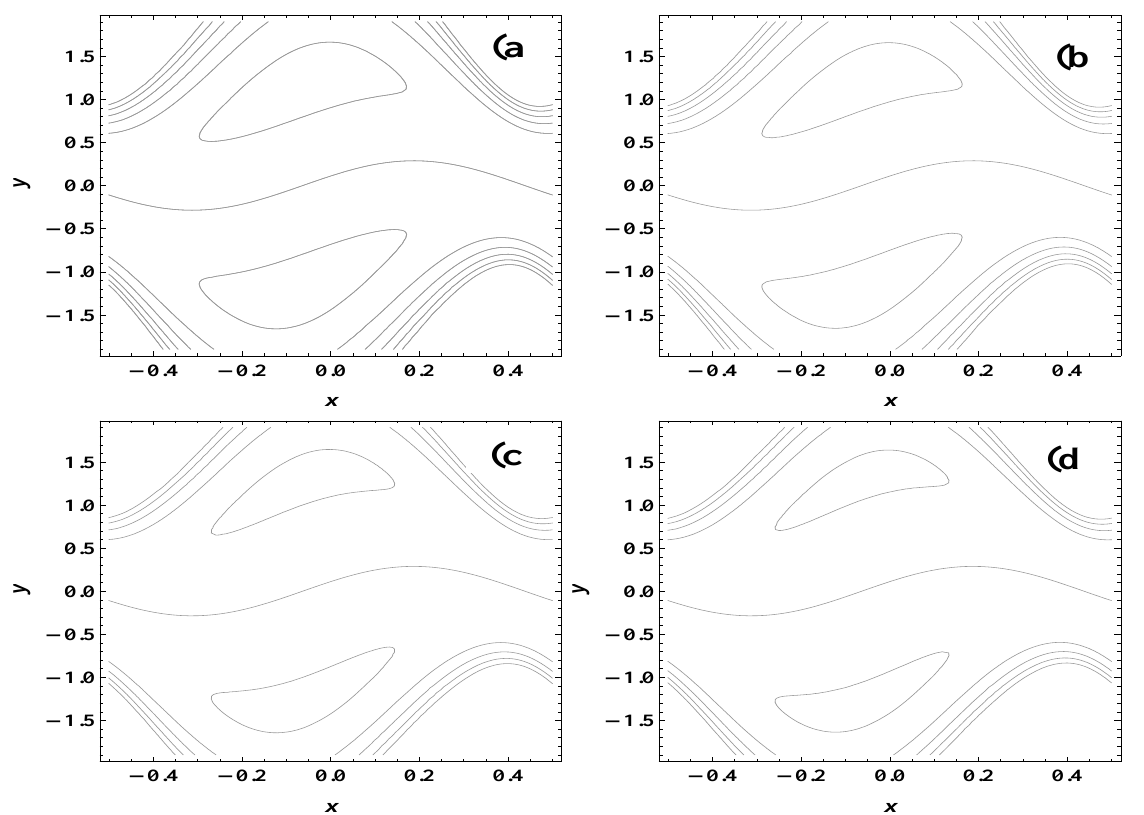
Figure 6. Effect on trapping by ϕ with Q = 1.48, M = 1.2, λ 1 = 1, (a); ϕ =0,(b); ϕ = π /6,(c); ϕ = π /3,(d); ϕ = π /2.